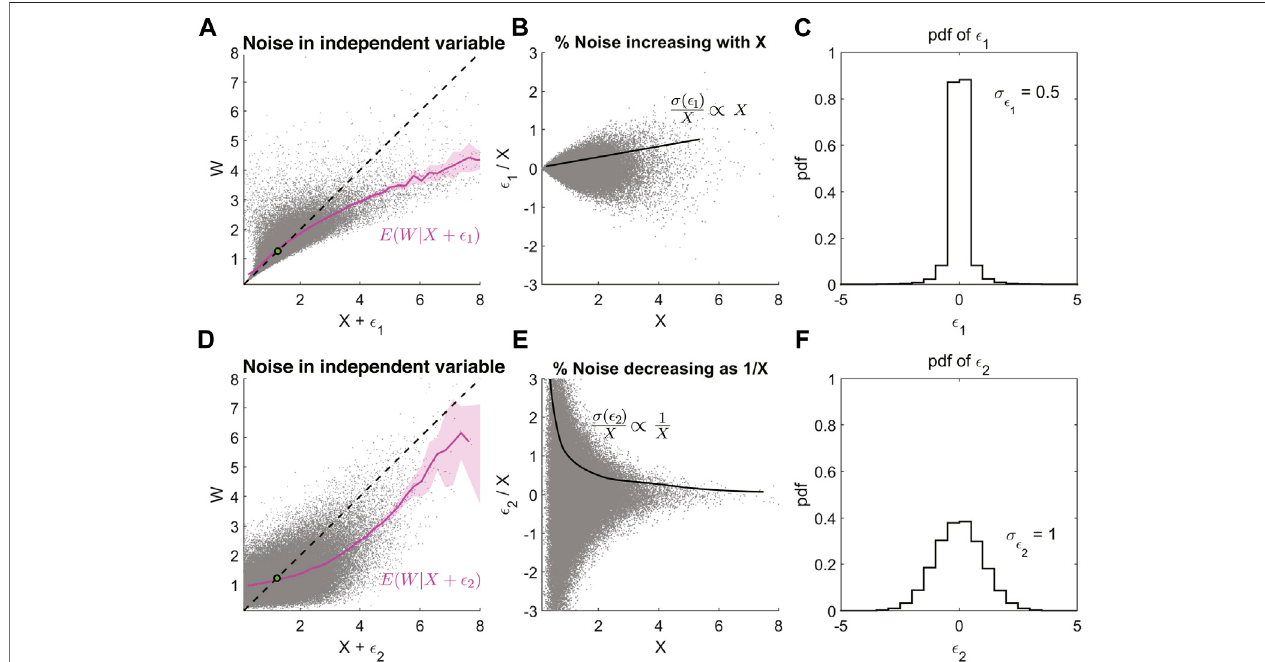
FIGURE6| Theseverityoftheregressionbiasatextremesisnotdeterminedonlybythestandarddeviationoftheuncertainty ϵ .Itisalsonecessarytoknowhowthe noise is correlated with the independent variable. (A) Magenta line is the E ( W | X + ϵ 1 ) where ϵ 1 is correlated Gaussian noise. (B) Fractional error or noise ϵ 1 / X increasing linearlywith X ,since σ ( ϵ 1 ) ∝ X 2 . (C) Themarginalprobabilitydistributionof ϵ 1 ,withthestandarddeviationof ϵ 1 =0.5. (D) Sameas (A) butwithuncorrelatedGaussiannoise ϵ ϵ σ ( ϵ 2 addedto X . (E) Fractionalerrorornoise 2 / X decreasingas1/ X ,since 2 )= constant . (F) Themarginalprobabilitydistributionof